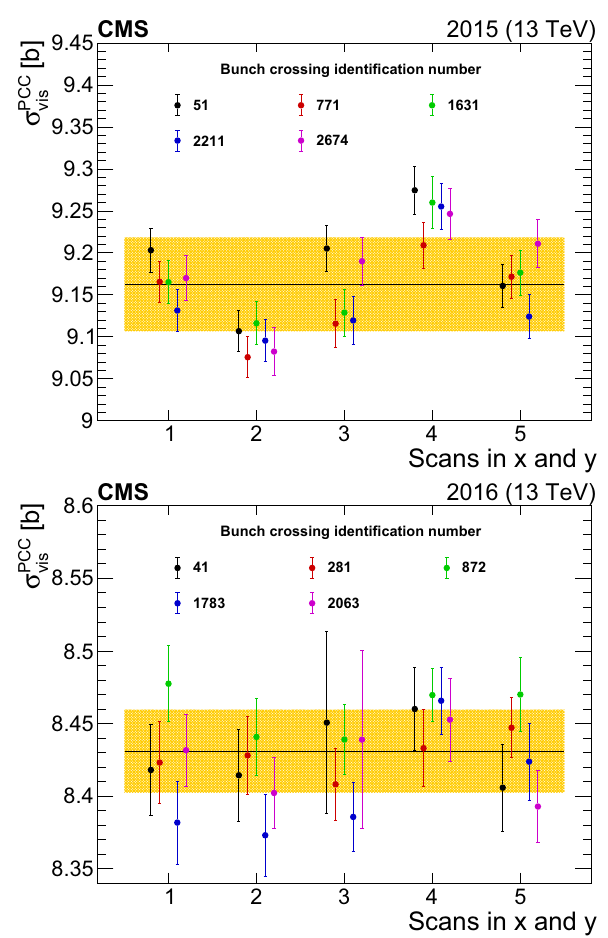
Fig. 6 The measured σ PCC , corrected for all the effects described in vis Sect. 4.3, shown chronologically for all vdM scan pairs (where 3 and 4 are BI scans) taken in fills 4266 (upper) and 4954 (lower), respectively. Each of the five colliding bunch pairs is marked with a different color. The error bars correspond to the statistical uncertainty propagated from the vdM fit to σ PCC . The band is the standard deviation of all fitted vis σ PCC vis